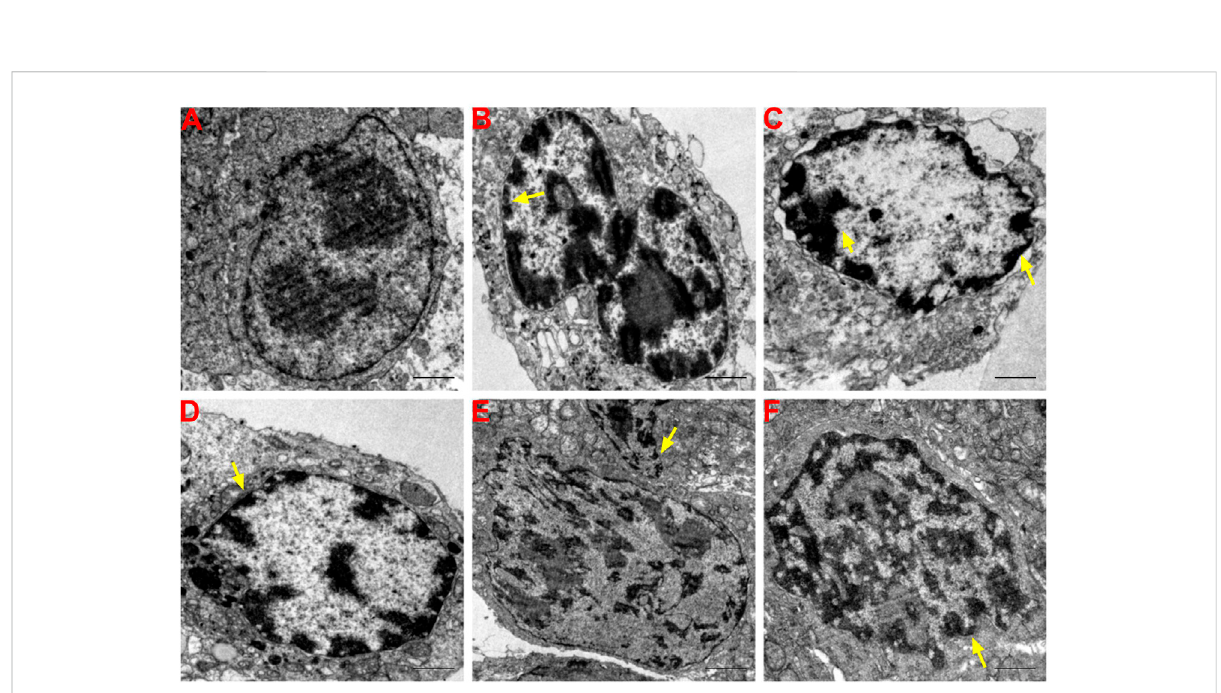
FIGURE 4 Effects of SFA/matrine+5-FU on ultramicropathological changes and apoptosis of tumors in BGC-823-transplanted nude mice. Sections were stained with UA and LC and viewed with a transmission electron microscope at a magni fi cation of ×8000. Scale bar = 2 μ m. Yellow arrows indicate nuclear pyknosis and cell membrane destruction. (A) Model control (negative control). (B) 5-FU control (0.01 g/kg) (positive control). (C) SFAD (0.2 g/kg)+5-FU (0.01 g/kg). (D) Matrine (4.03 mmoL/L)+5-FU (0.01 g/kg). (E) SFAD (0.2 g/kg). (F) Matrine (4.03